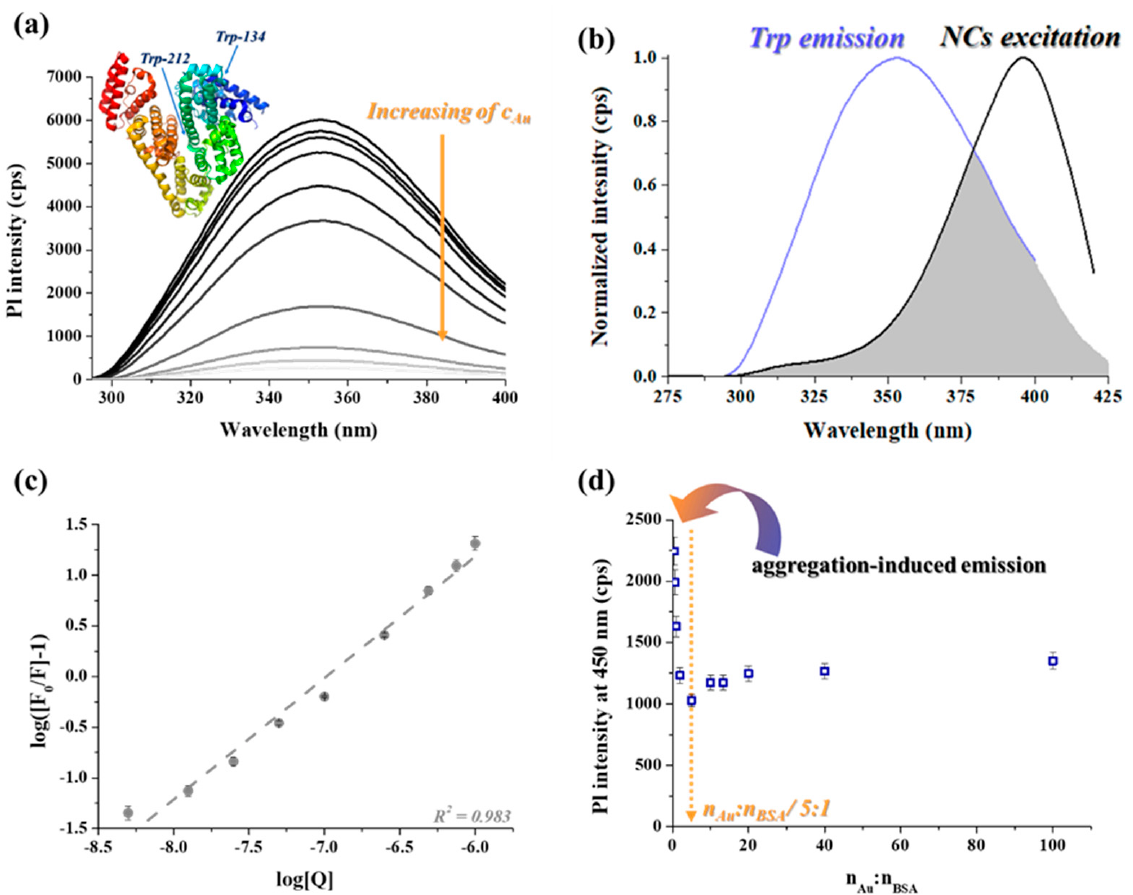
Figure 4. ( a ) The emission spectra of the BSA after addition of 0–1 mM Au NCs with the structure of BSA (PDB code: 3V03) (c BSA = 0.5 mM; T = 25 °C; λ ex = 280 nm). ( b ) The normalized emission spectrum of the Trp in BSA and the excitation spectrum of the B 1 -Au NCs. ( c ) The Scatchard plot of